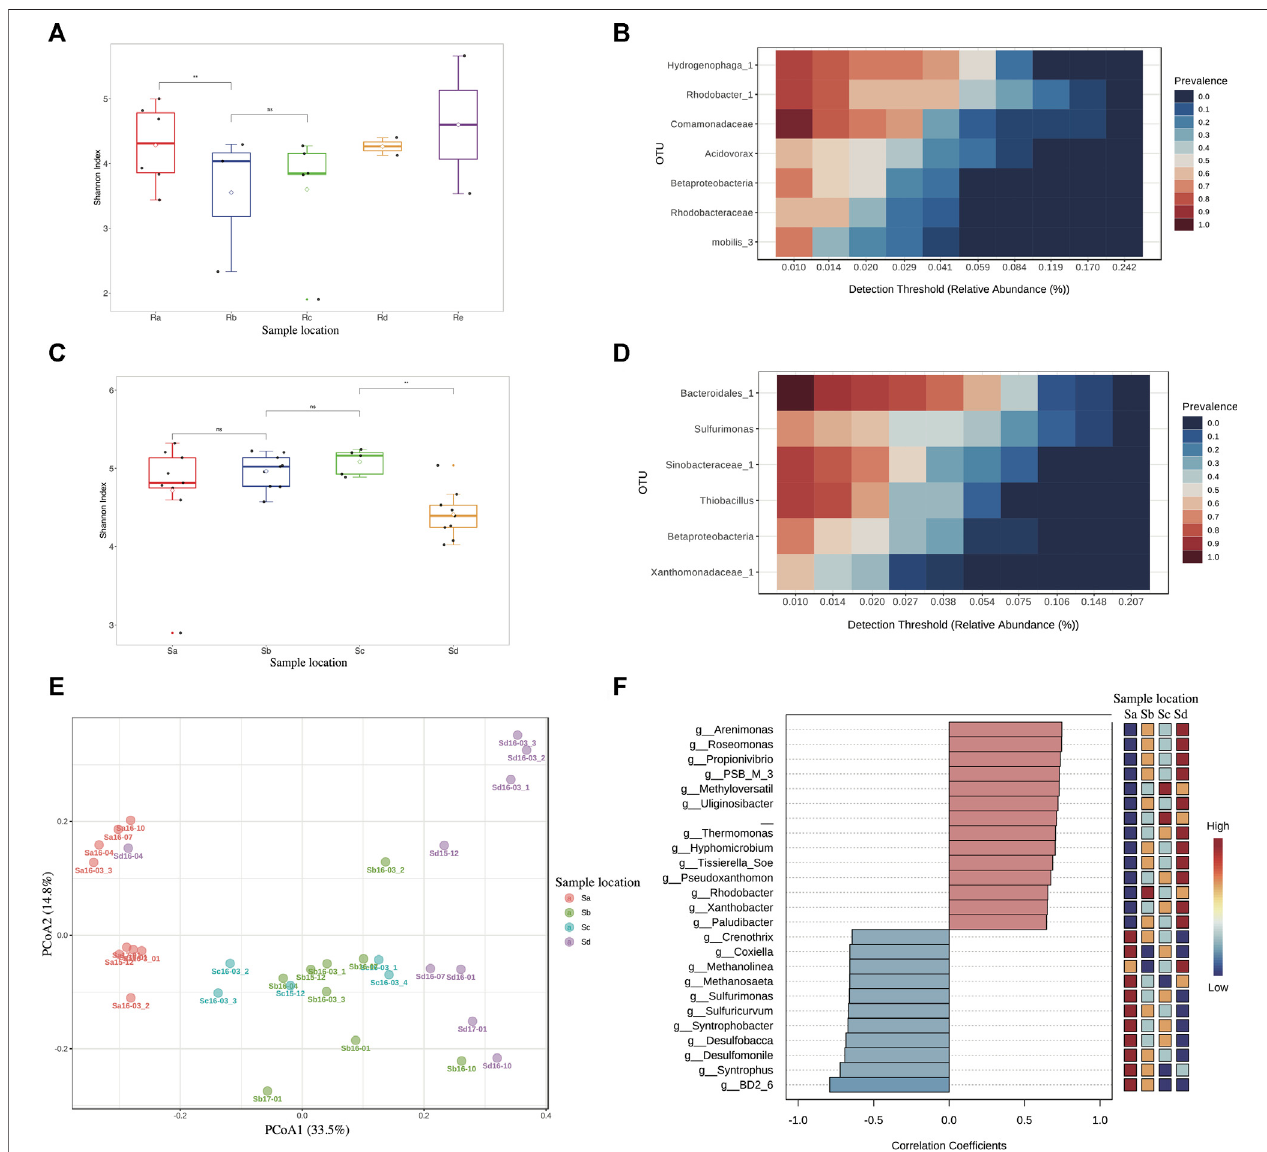
FIGURE 3 | Microbial community composition of stream water and sediment samples at OTU level. (A) SHDI of stream water samples. (B) Core Microbiome analysis of stream water samples. (C) SHDI of sediment samples. (D) Core Microbiome analysis of sediment samples. (E) PCoA of sediment samples based on Bray- Curtis Index. (F) Pattern Search analysis of sediment